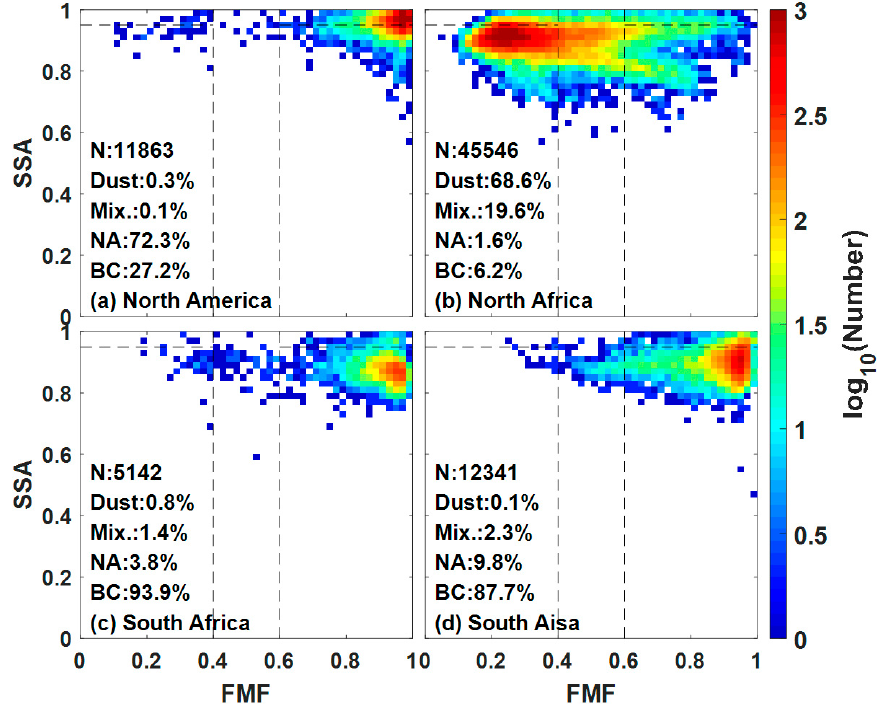
Figure 1. Scatterplots of FMF and SSA in four typical regions: ( a ) North America; ( b ) North Africa; ( c ) South Africa; and ( d ) South Asia. Abbreviation in this figure: Mix. (Mixture), non-absorbing (NA), black carbon (BC), single-scattering albedo (SSA) and fine-mode fraction (FMF).